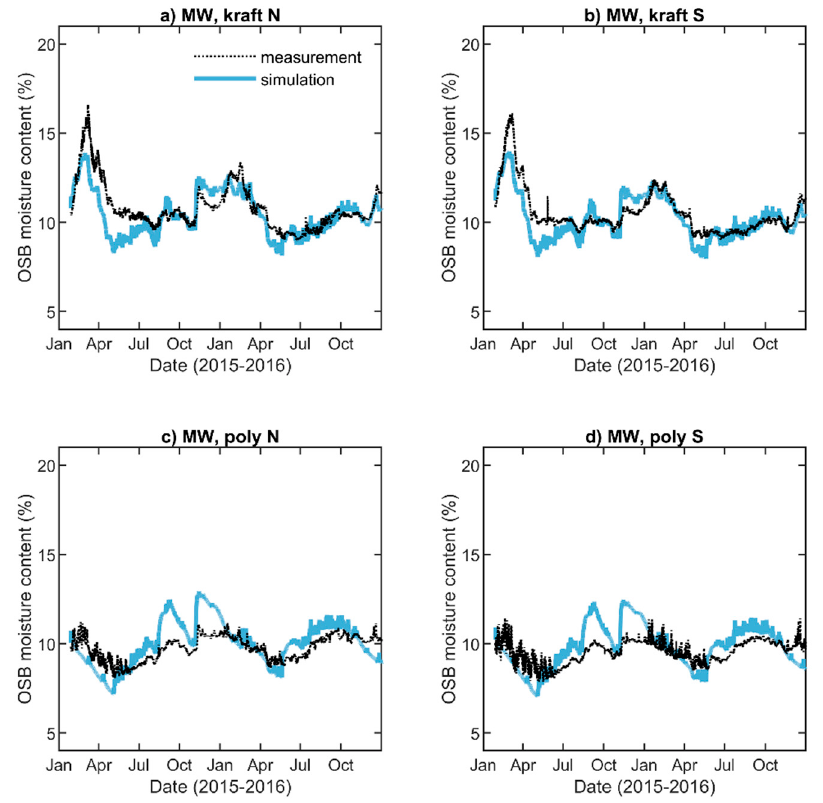
Figure 15. Measured and simulated moisture content of OSB for walls with MW insulation.